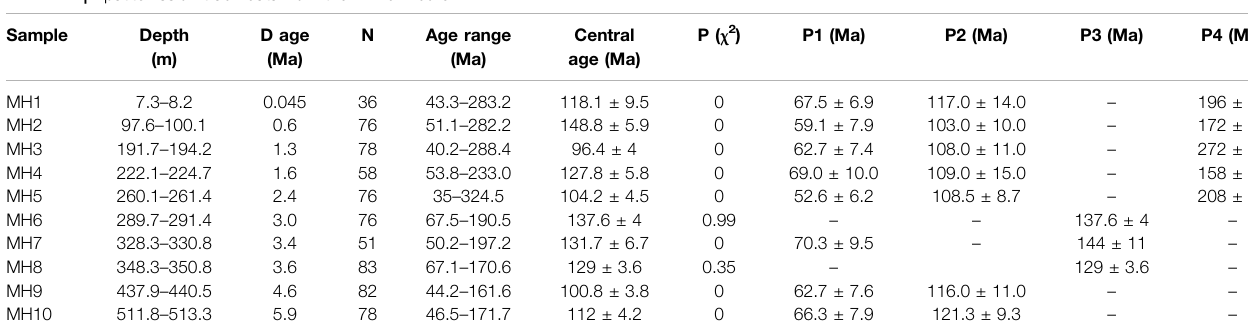
TABLE 1 | Apatite fi ssion track data from the MH drill core